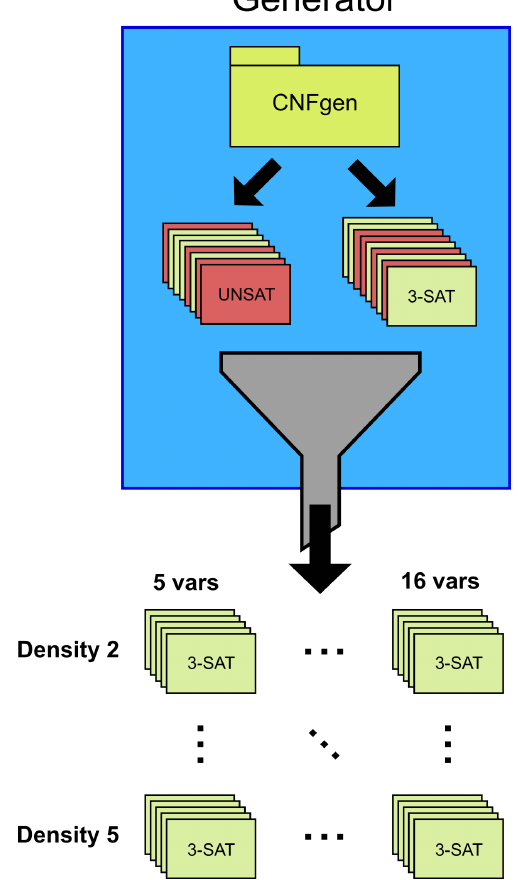
Figure 3. Test cases generator